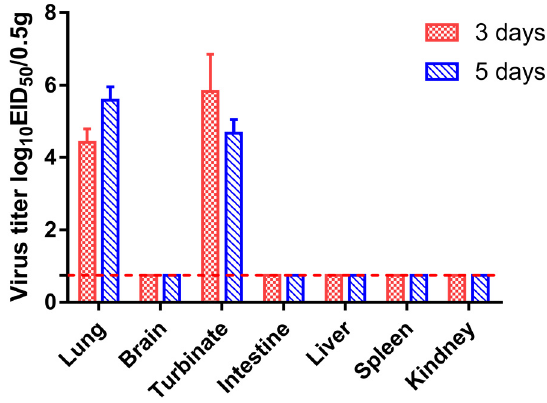
Figure 6. Tissue tropism of the new clade (represented by qk01/2017) CIV. Mice ( n = 3) were infected with 10 6 EID 50 of the qk01/2017 isolate. Lung, nasal turbinate, brain, liver, spleen, kidney, and intestine samples were collected, and viral titers were determined at 3 and 5 dpi. The dotted line indicates the detection limit.